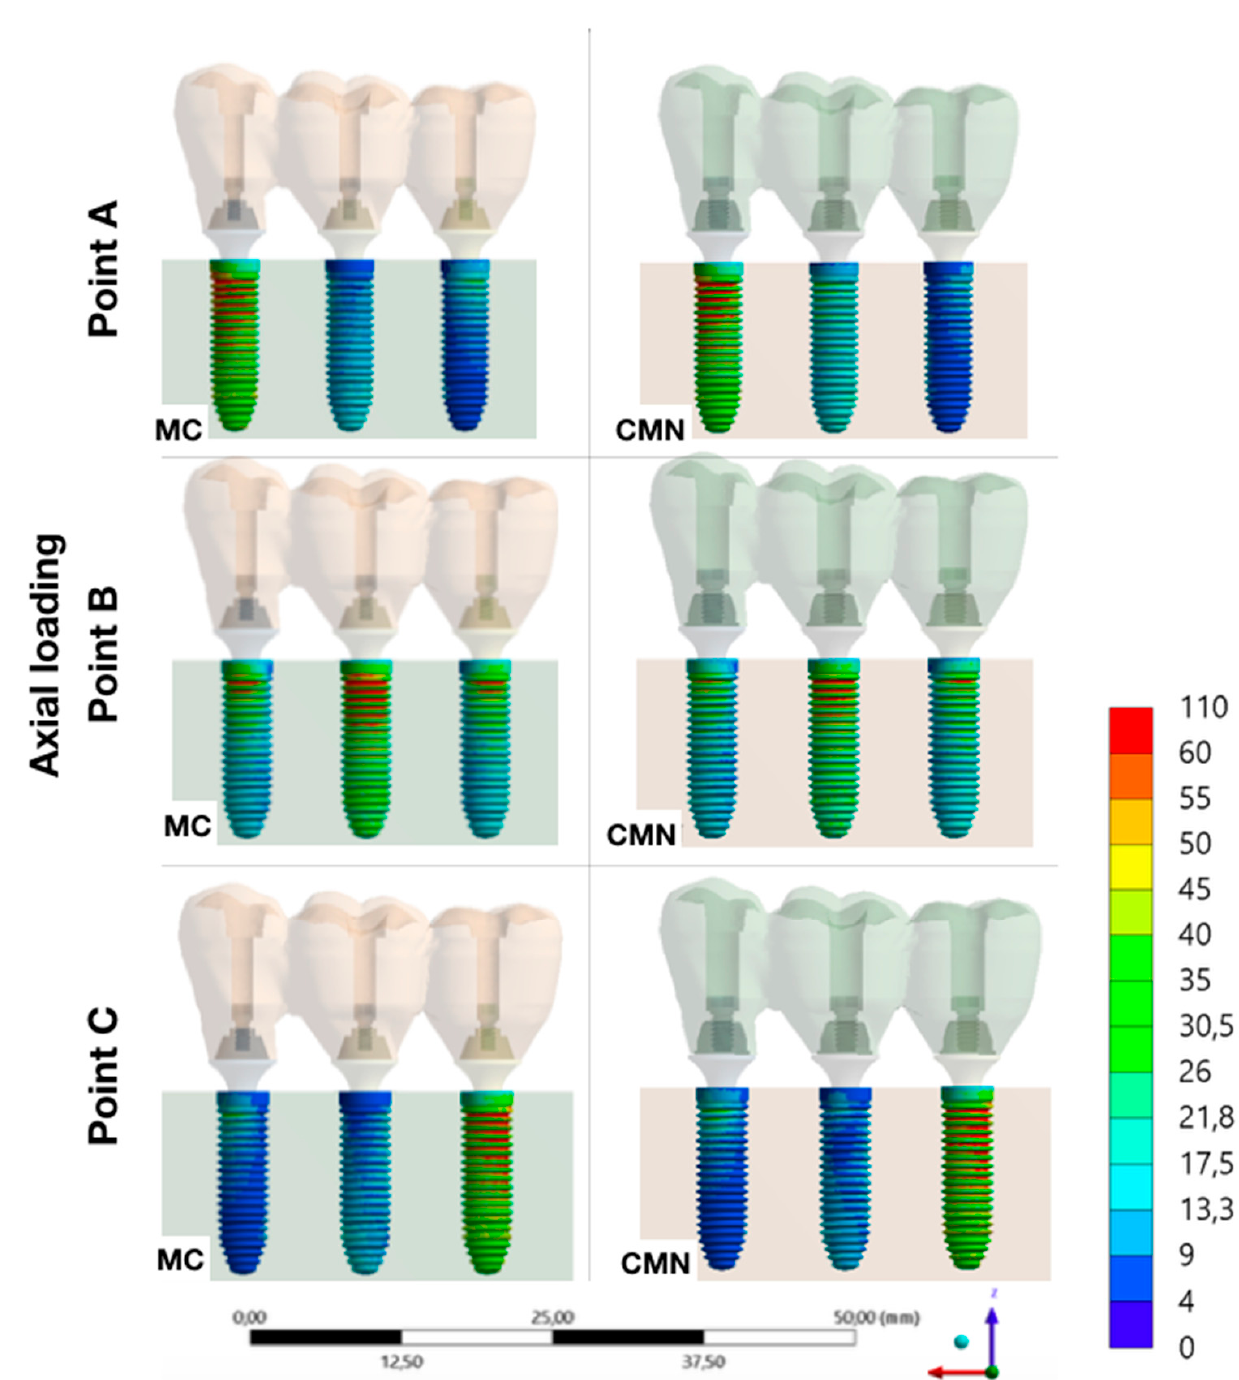
Figure 10. Maximum principal stress (MPa) at the implants for the load application at points A, B, and C (CMN and MC groups).